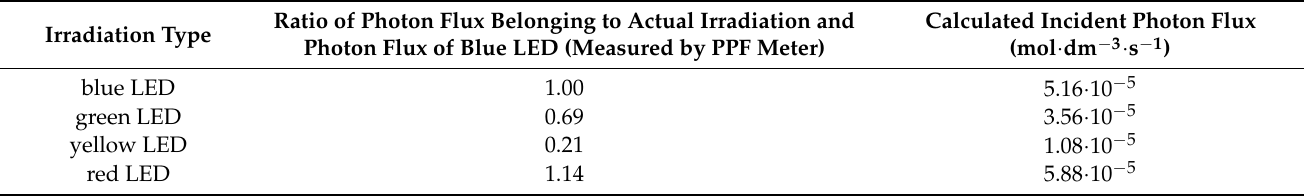
Table 3. Incident photon fluxes under green, yellow, and red irradiation obtained from the